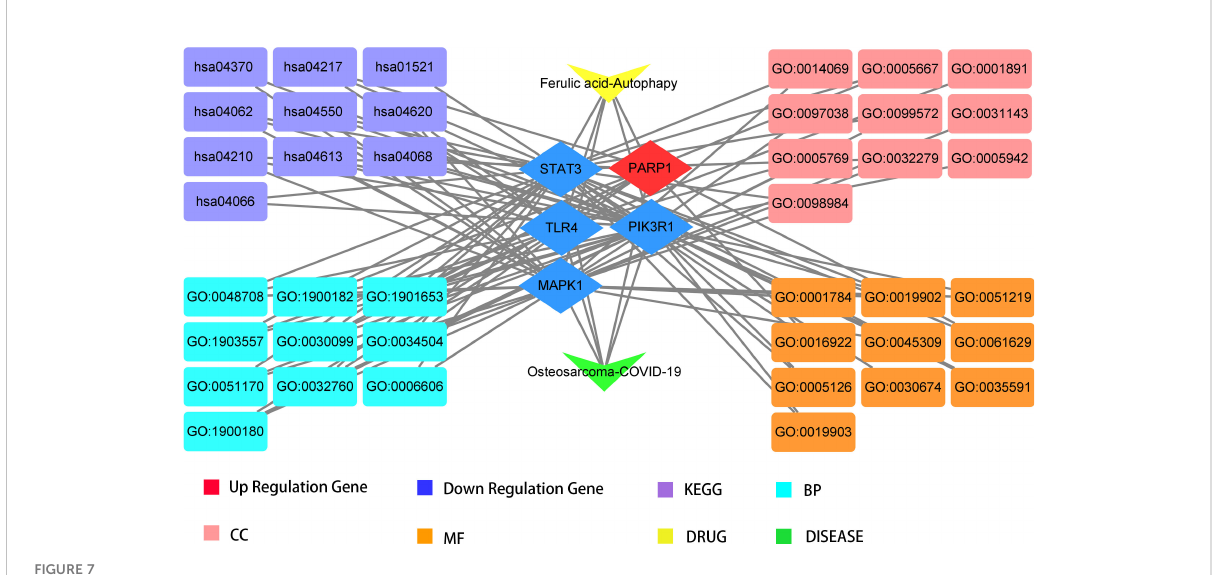
FIGURE 7 Visualization of the detailed fi ndings in our bioinformatics